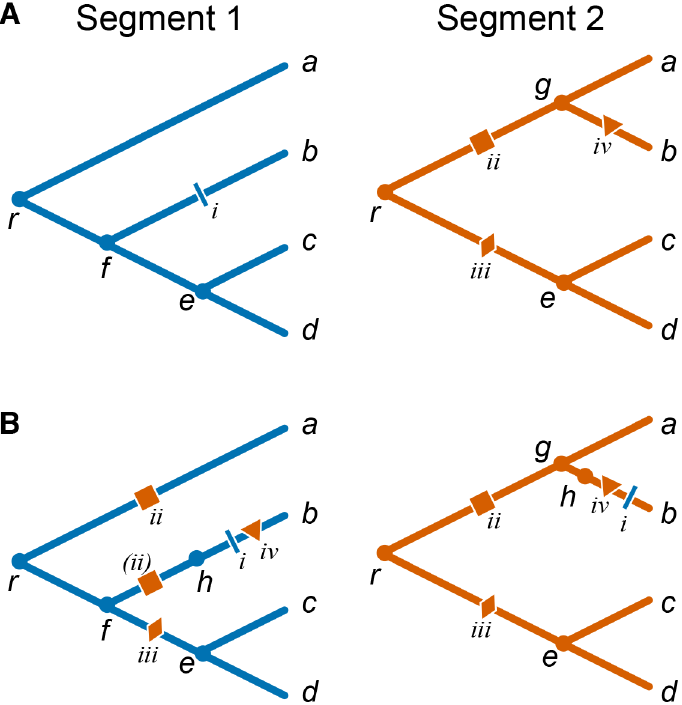
Fig 1. Mapping mutations between segments in the presence of reassortments. (A) Individual toy phylogenies for segments 1 (left) and 2 (right) with respective mutations. (B) Segment 1 phylogeny with segment 2 “ background ” mutations mapped onto it (left) and segment 2 phylogeny with segment 1 “ background ” mutations mapped onto it (right). a – d , leaf nodes; e – g , internal nodes; h , virtual node arising due to the reassortment event; r , root node; nodes corresponding to the two segments of the same isolate are denoted with the same letter. Each mutation is identified by a roman numeral and a unique symbol colored according to the segment in which it occurred. Mutation ii in segment 2 maps onto two branches of the segment 1 phylogeny, once as a regular mutation onto branch ra and once as a virtual mutation (denoted by parentheses) onto branch fh